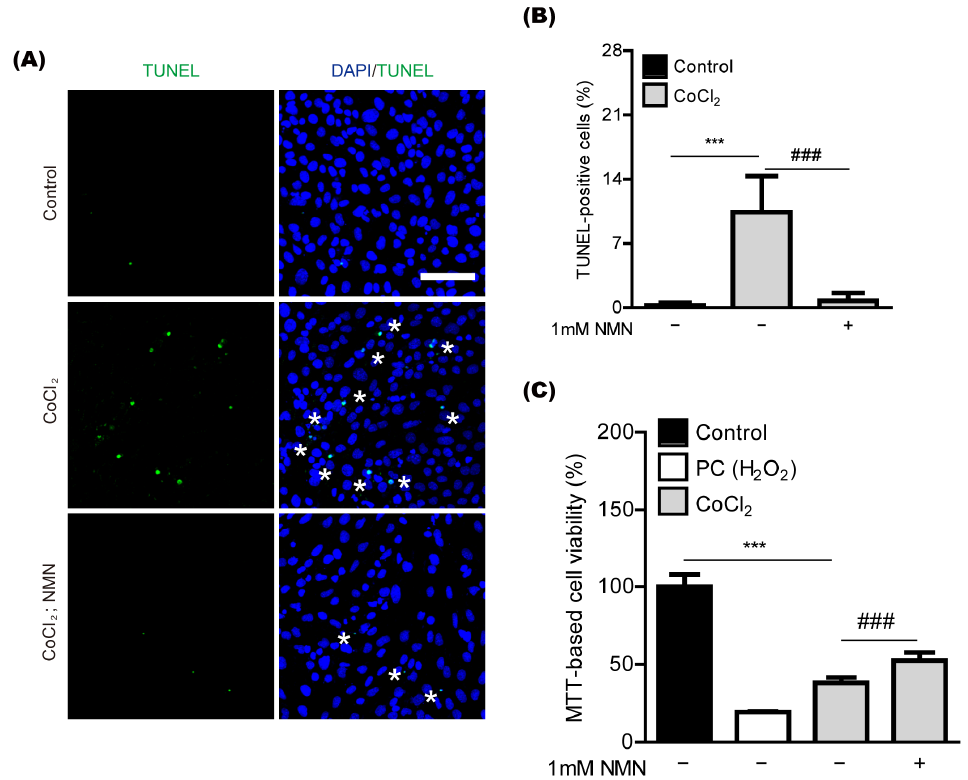
Figure 3. Neuroprotection in vitro by nicotinamide mononucleotide (NMN) treatment. ( A , B ) Rep- resentative pictures and quantitative analyses ( n = 5 per group) demonstrated that the amount of oxidative stress-induced 661W cell death stained by TUNEL assay was reduced by 1 mM NMN treatment after 24 h of 400 μ M of CoCl 2 incubation. Scale bar: 100 μ m. DAPI (blue); TUNEL (green); Stars (*) in pictures, TUNEL positive cells. *** p < 0.001 and ### p < 0.001. One-way ANOVA followed by a Bonferroni post-hoc test was used for the data analysis. Graphs are depicted as the mean ± standard deviation. ( C ) Quantitative analyses ( n = 9 per group) demonstrated that MTT-based 661W cell viability increased by 1 mM NMN treatment after 10 h of 400 μ M of CoCl 2 incubation. *** p < 0.001 and ### p < 0.001. One-way ANOVA followed by a Bonferroni post-hoc test was used for the data analysis. Bar graphs are shown as the mean ± standard deviation. PC, positive control (250 µ M of H 2 O 2 ).